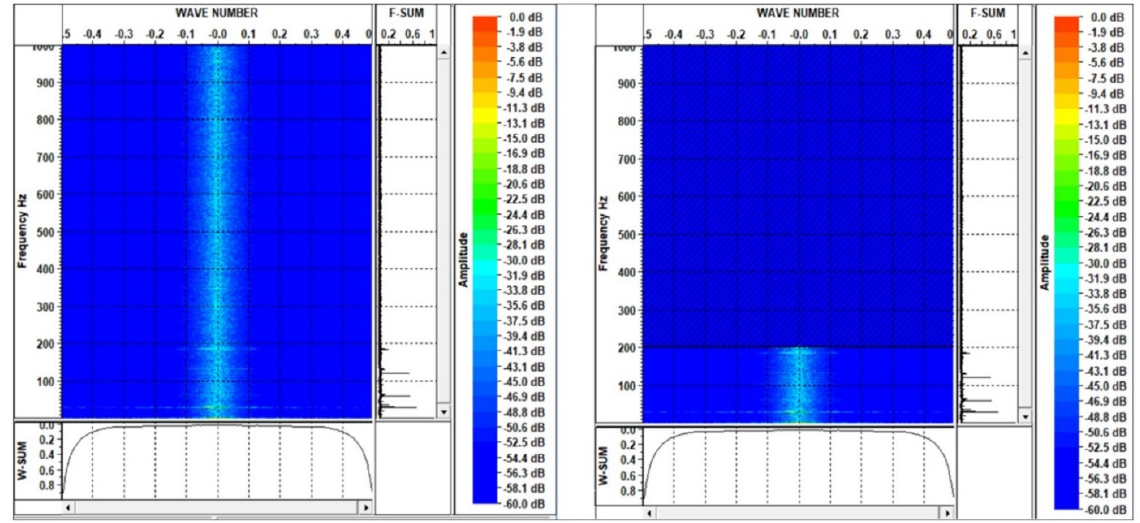
Figure 3. The DAS data processing workflow.